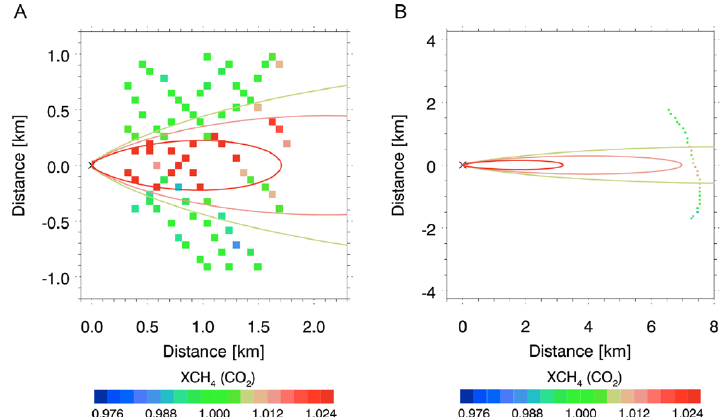
Fig. 10. Data used for the inversion of the near part of Theodor Shaft (panel A ) and the far part (panel B ). Contour lines indicate the result from the Gaussian plume model inversion.